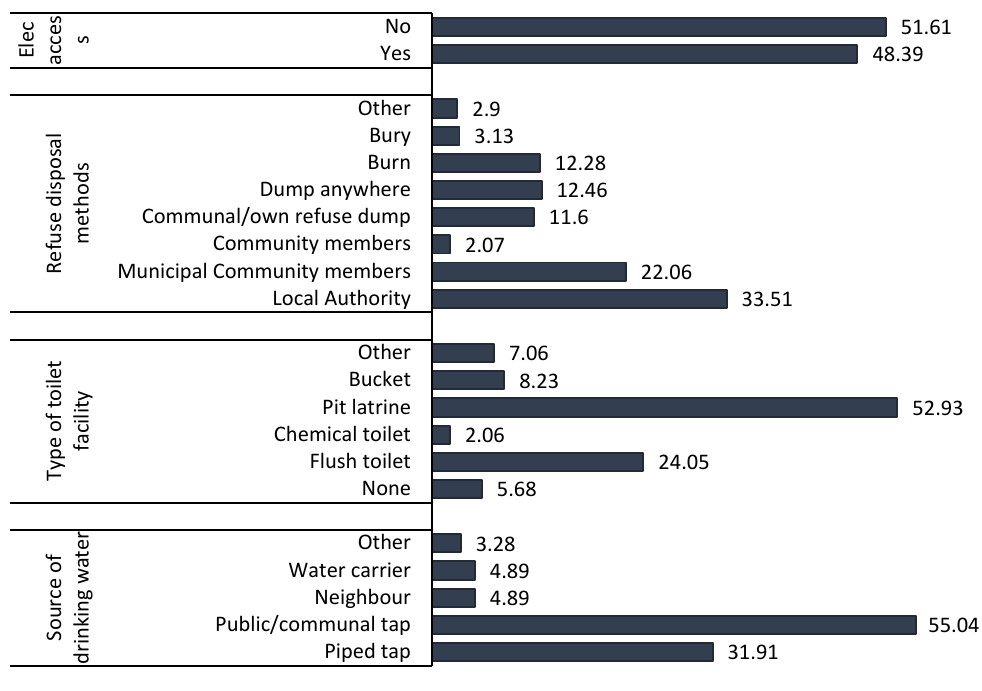
Table 1. Demographic characteristics of study sample.